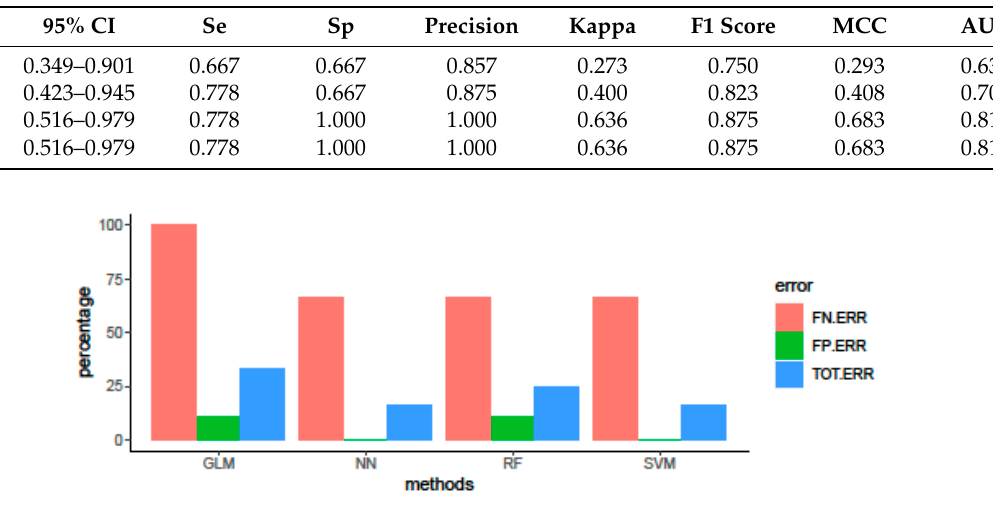
Figure 3. False negative error (FN.ERR), false positive error (FP.ERR) and total error (TOT.ERR) in predicting the probiotic/non-probiotic status on the test set of four ML methods: GLM, RF, SVM and